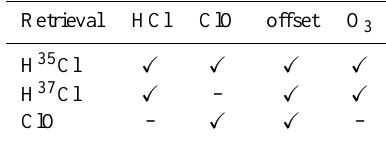
Table 2. Overview of the retrieved parameters for each